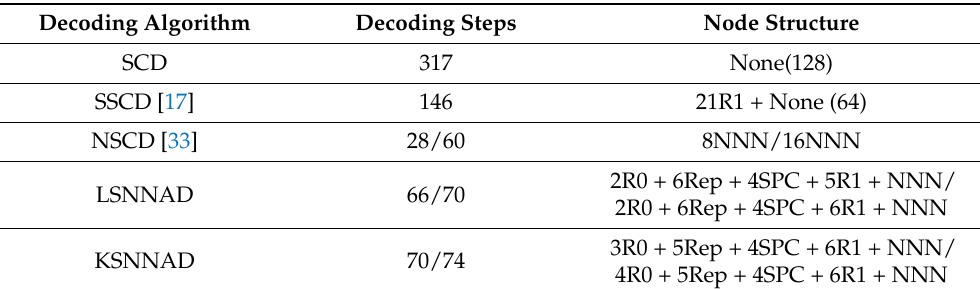
Table 5. Comparison of decoding steps. Decoding